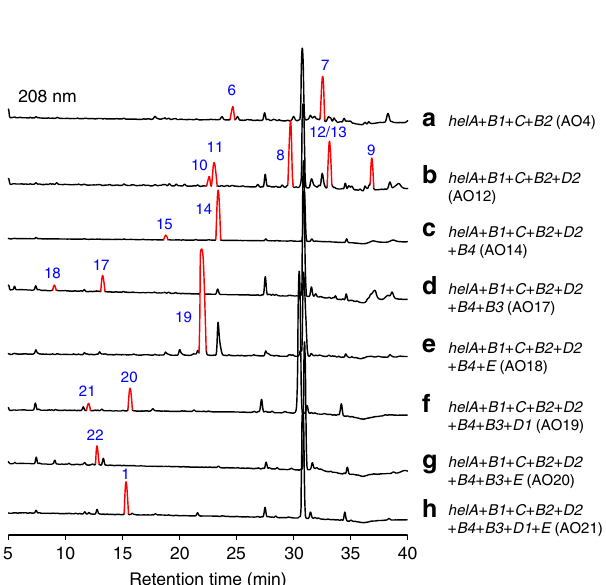
Fig. 2 HPLC analysis of mycelia extract from different transformants. a A.